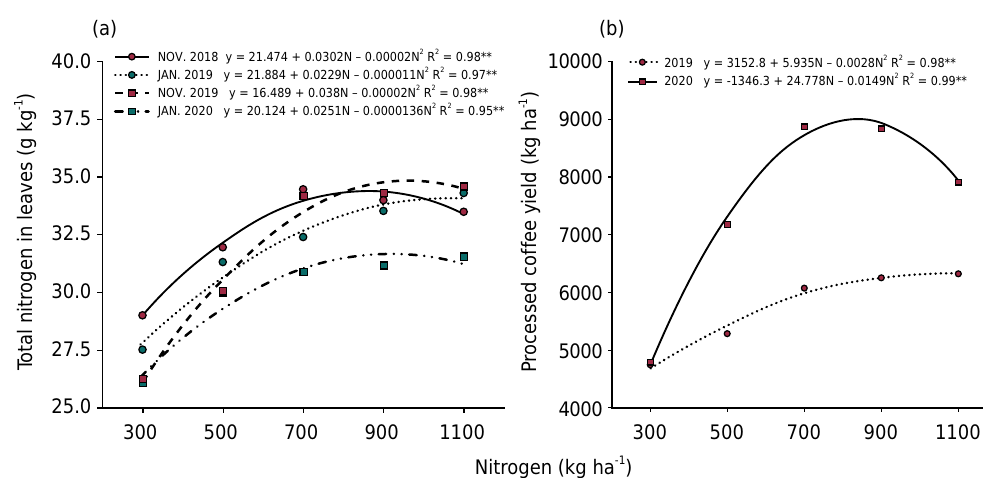
Figure 6. Concentration of total nitrogen in leaves of Conilon coffee (a) and processed coffee yield (b), for the harvests 2018/2019 and 2019/2020, in response to the application of nitrogen doses. ** significant at 1 % probability.